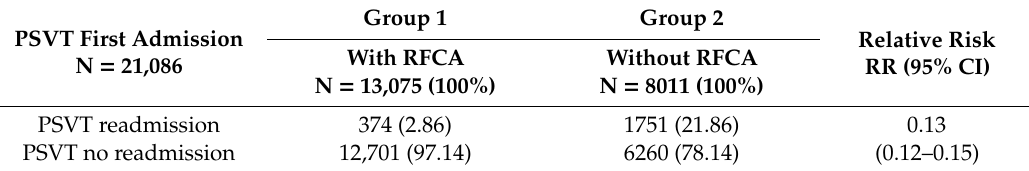
Table 4. Relative risk of PSVT-related readmission in patients who underwent RFCA and those who did not.